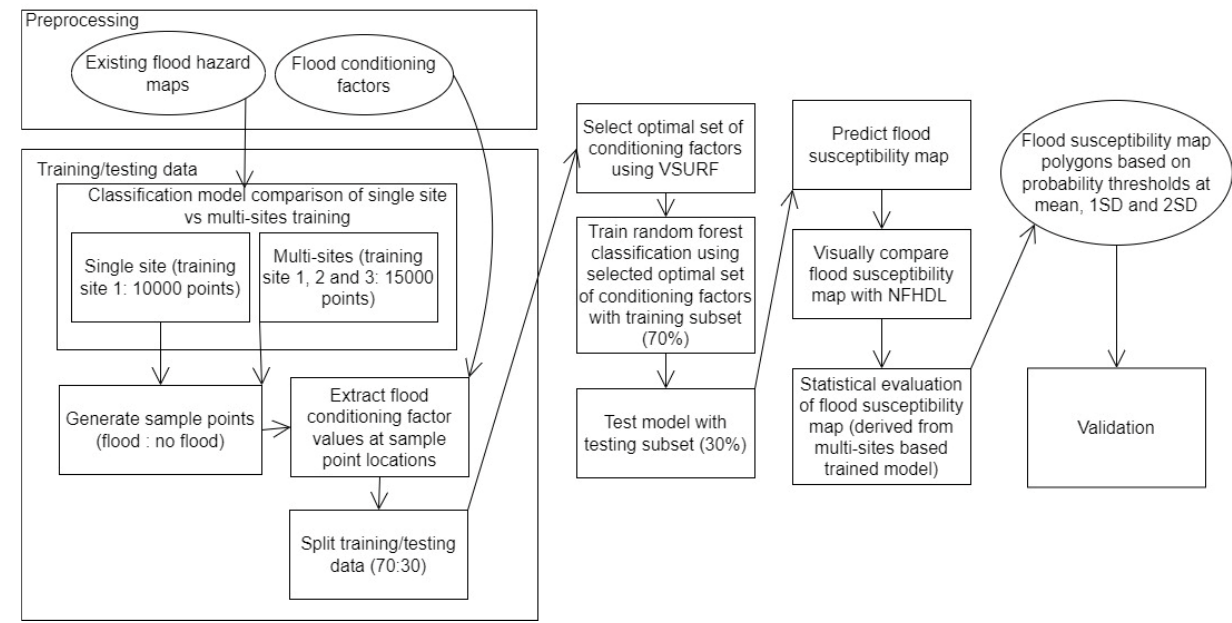
Figure 4. Flowchart describing the training and validation steps of the classification approach.